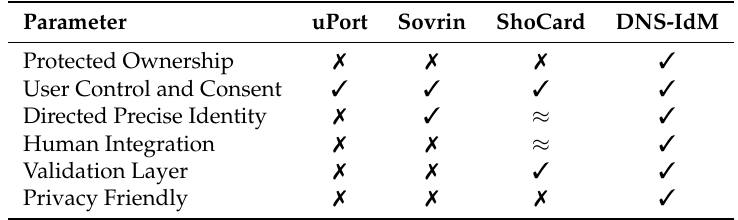
Table 2. The security comparison of DNS-IdM with 3 advanced identity management